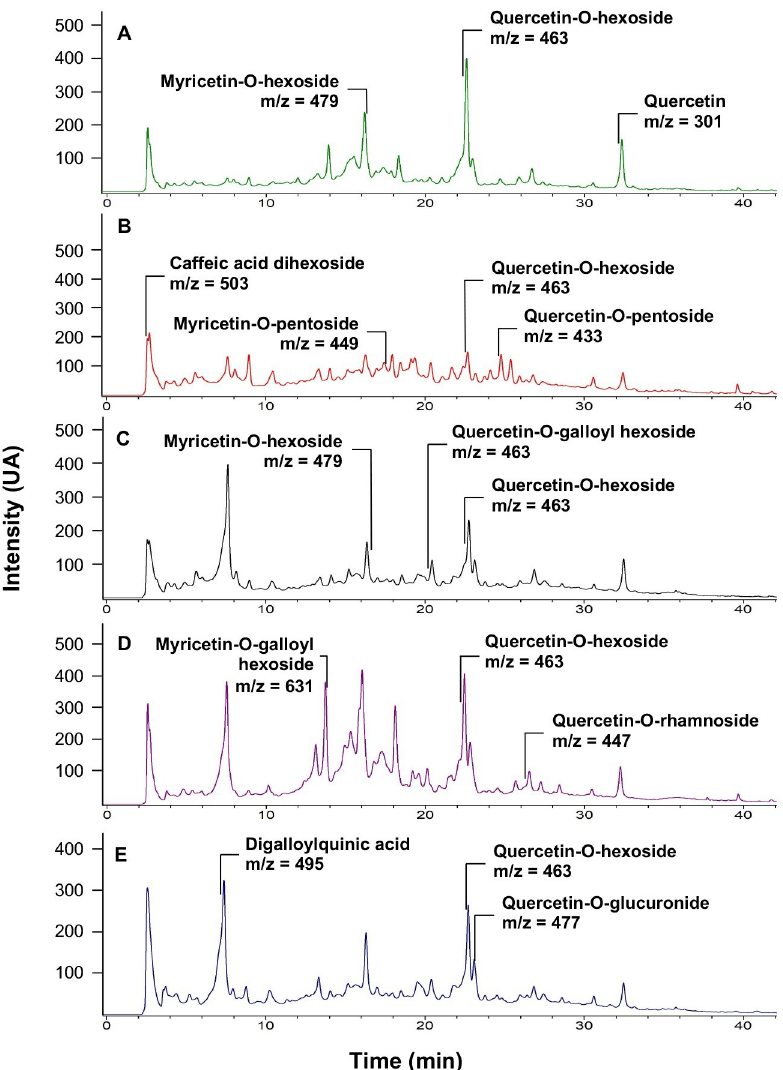
Fig 7. LC-UV chromatograms (280 nm) of the 5 selected ethanolic extracts (SEs) of U . molinae fruits from different genotypes obtained from the LC-MS/MS analysis. The LC-MS/MS data was analyzed using Bruker DataAnalysis 3.2 software (Bruker Daltonik GmbH, DE). Tentative identification of phenolic compounds was carried out by molecular ion mass and fragmentation pattern comparison with a library and the ReSpect for Phytochemicals database. Some of the compounds detected in each extract are shown. (A) ETE 14–4 LC-UV chromatogram. (B) ETE 19–1 LC-UV chromatogram. (C) ETE 19-1ha LC-UV chromatogram. (D) ETE 23–2 LC-UV chromatogram. (E) ETE 27–1 LC-UV